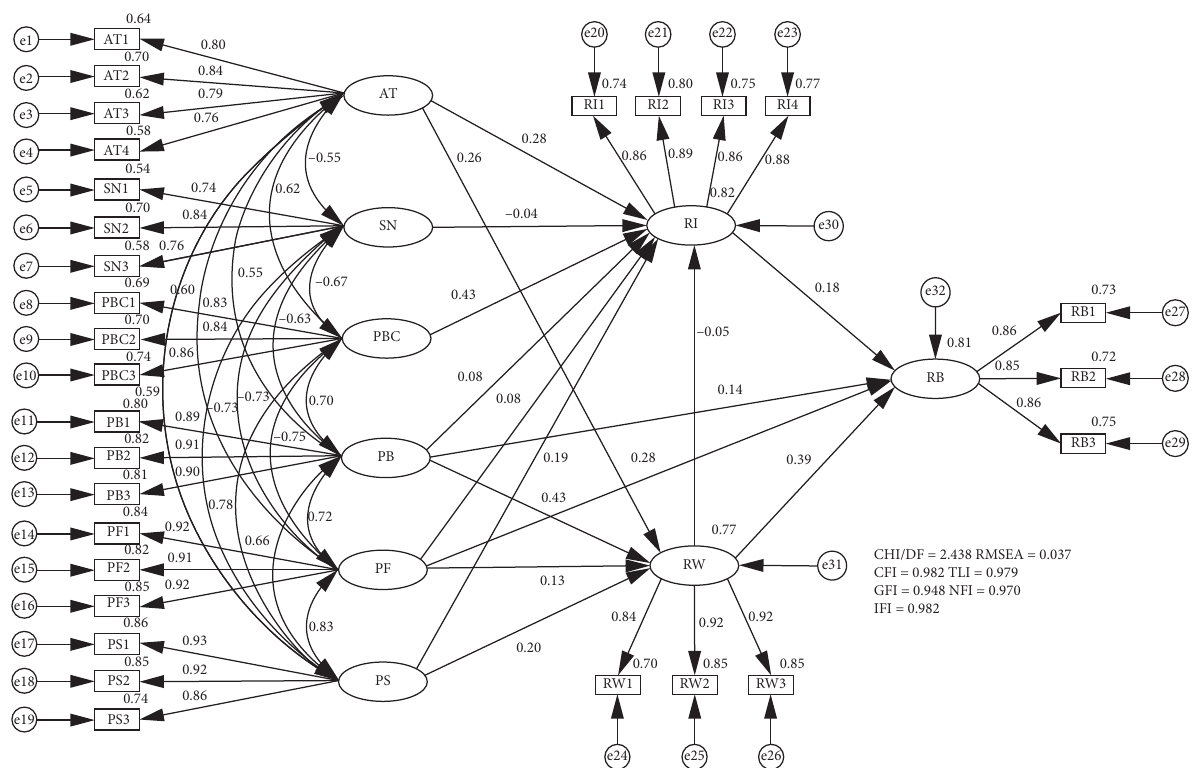
Figure 6: The modified TPB-PWM model for e-bikers’ RLR